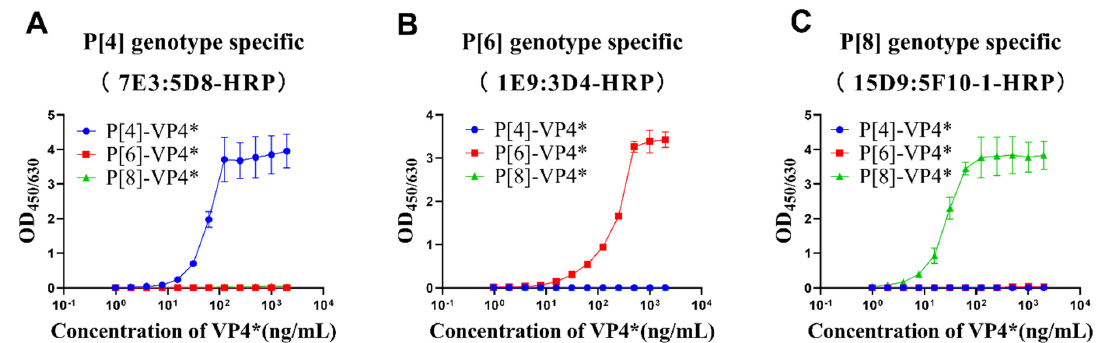
Figure 2. The detection range and specificity of P[4], P[6], and P[8]-VP4*-specific detection systems. The purified VP4* proteins were 2-fold serially diluted from 2 μ g/mL to 0.97 ng/mL by 20% NBS, and detected by P[4], P[6], and P[8]-specific VP4* detection system. ( A ) The reactivity of P[4]-VP4* antibody pair 7E3:5D8-HRP to different genotype VP4* proteins; ( B ) the reactivity of P[6]-VP4 antibody pair 1E9:3D4-HRP to different genotype VP4 proteins; ( C ) the reactivity of P[8]-VP4* antibody pair 15D9:5F10-1-HRP to different genotype VP4* proteins. All the experiments were performed in three replicates, and the error bars represent the standard deviation of each group.